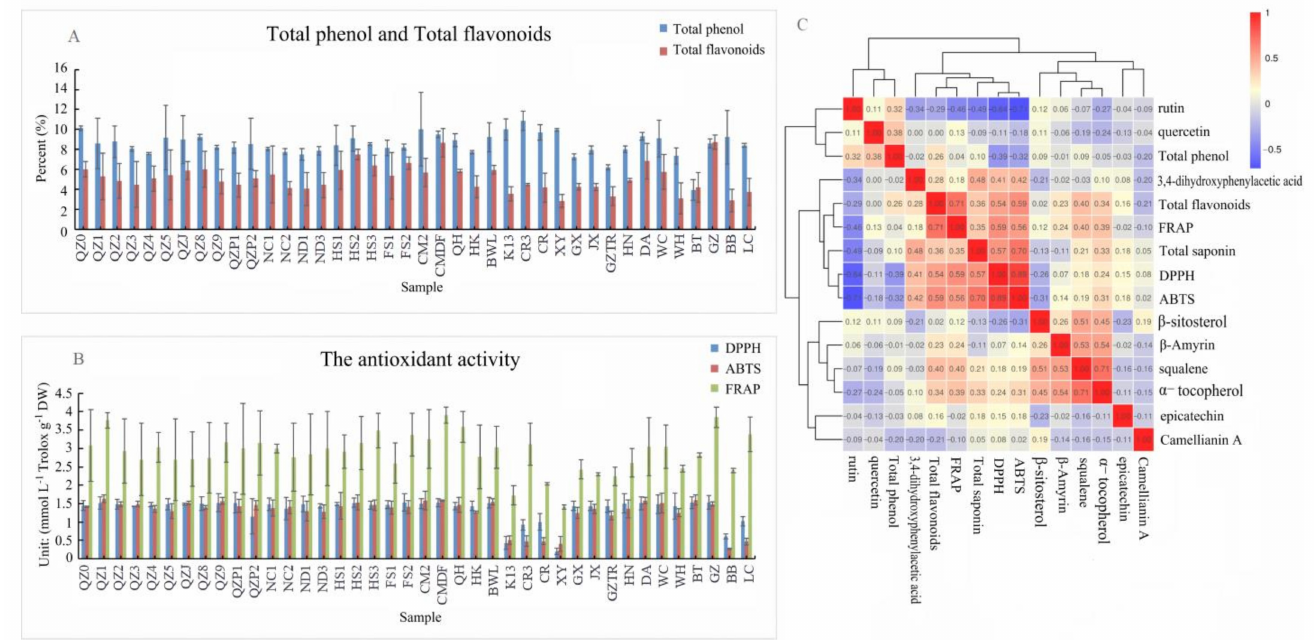
Figure 2. The content of total phenolic and total flavonoids and the antioxidant activities of 40 kinds of Camellia spp. ( A ): The content of total phenolic and total flavonoids; ( B ): The antioxidant activities ( p ≤ 0.01); ( C ): Correlation analysis on the content of active components and antioxidation index including DPPH, ABTS, and FRAP in Camellia spp.